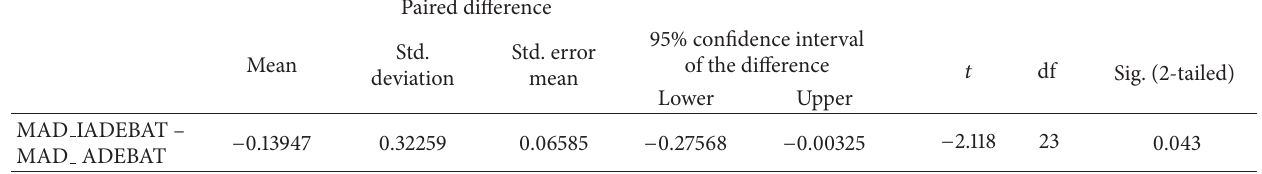
Table 4: Paired samples test between MADs of the IADEBAT and of the ADEBAT models. Paired difference Std. deviation